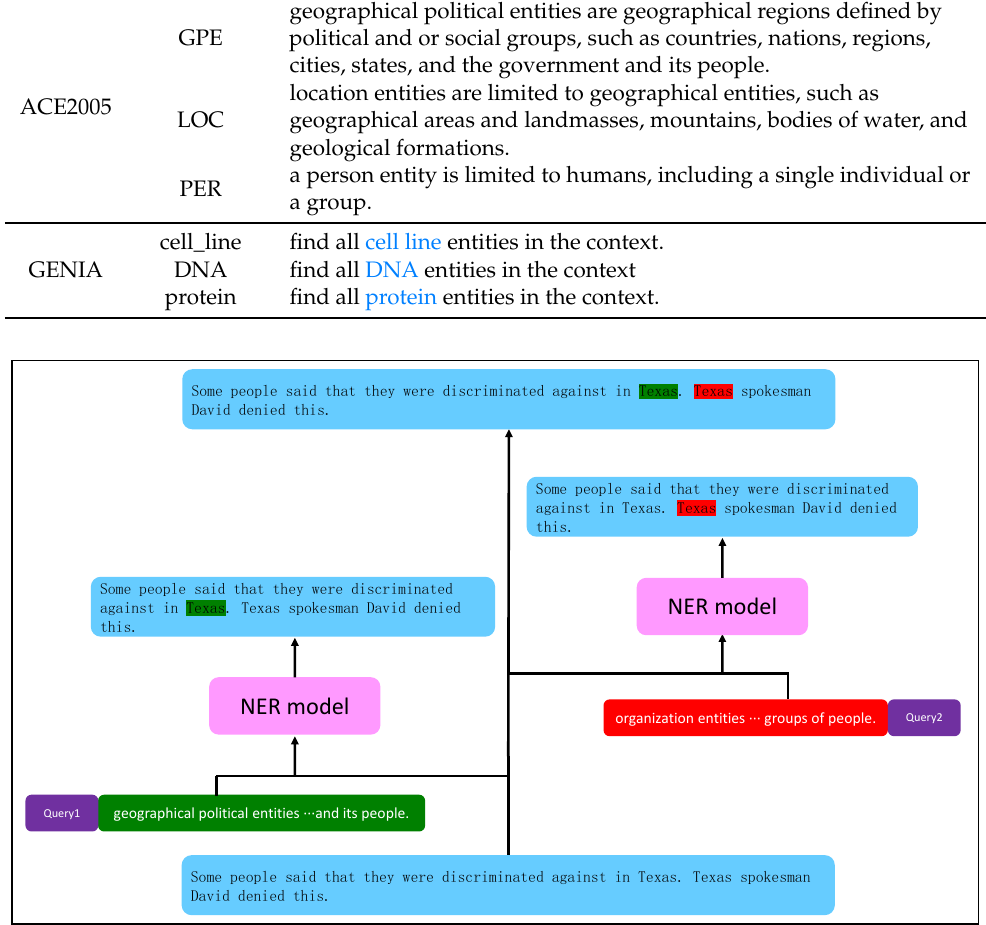
Figure 1. The process of recognizing entities, using a named entity recognition model, based on a machine reading comprehension